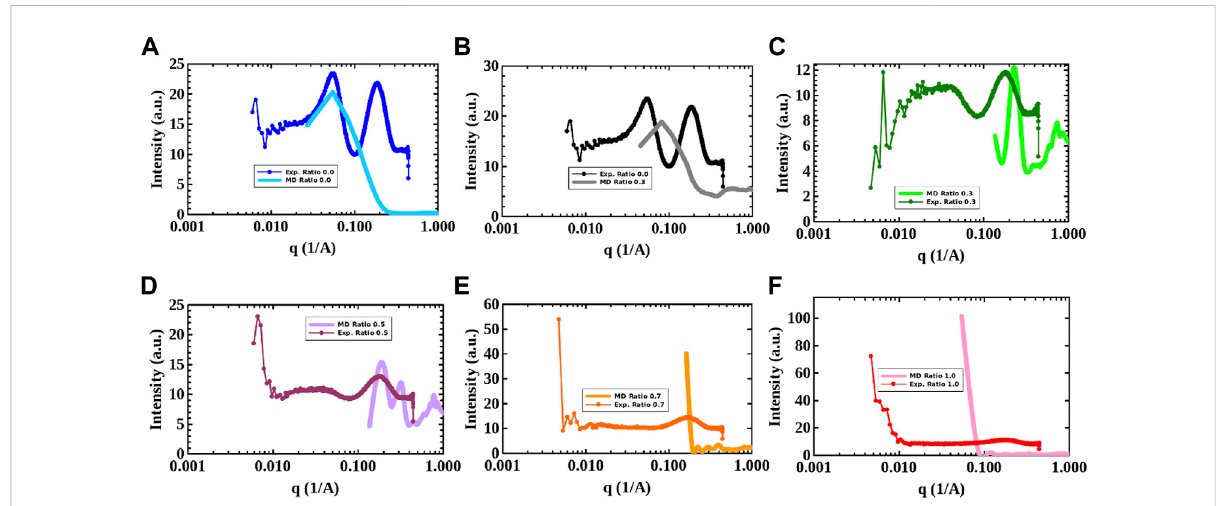
FIGURE 6 ComputedandexperimentalSAXSpro fi lesfor the (A) 0.0, (B) 0.1, (C) 0.3, (D) 0.5, (E) 0.7,and (F) 1.0[N 4,4,4,4 ] + /[DS] - molarratiosystemsshownin Figure 2. The SDS concentration in the experimental samples was 1wt% and the temperature was 298 K. Pro fi les colored in shadow are computed SAXS taken from the CG-MD